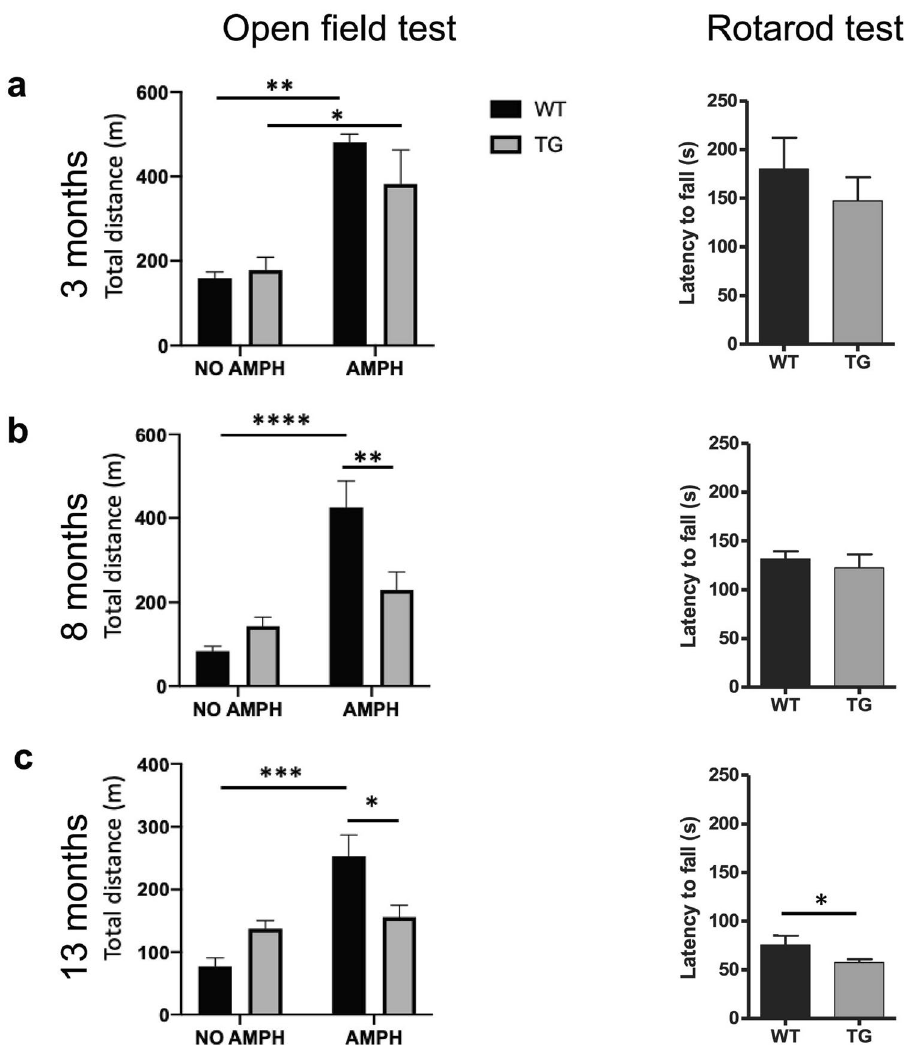
Figure 3. Progressively impaired motor function in TG mice. Open field motor test (left panel) showing distance travelled by WT and TG mice at naive condition and after amphetamine injection (5 mg/ kg) at ( a ) age of 3, ( b ) age of 8 and ( c ) age of 13 months, two-way ANOVA: *p-value < 0.05, **p < 0.01, ****p < 0.0001. Rotarod motor test (right panel) illustrating the latency to fall of accelerated rod in rotarod test at ( a ) age of 3 months (n = 3 WT, 5 TG), ( b ) age of 8 months (n = 7 WT, 7 TG) and ( c ) age of 13 months (n = 5 WT, 10 TG). Two-tailed student’s t-test: *p < 0.05. AMPH = amphetamine, m = meter, s =